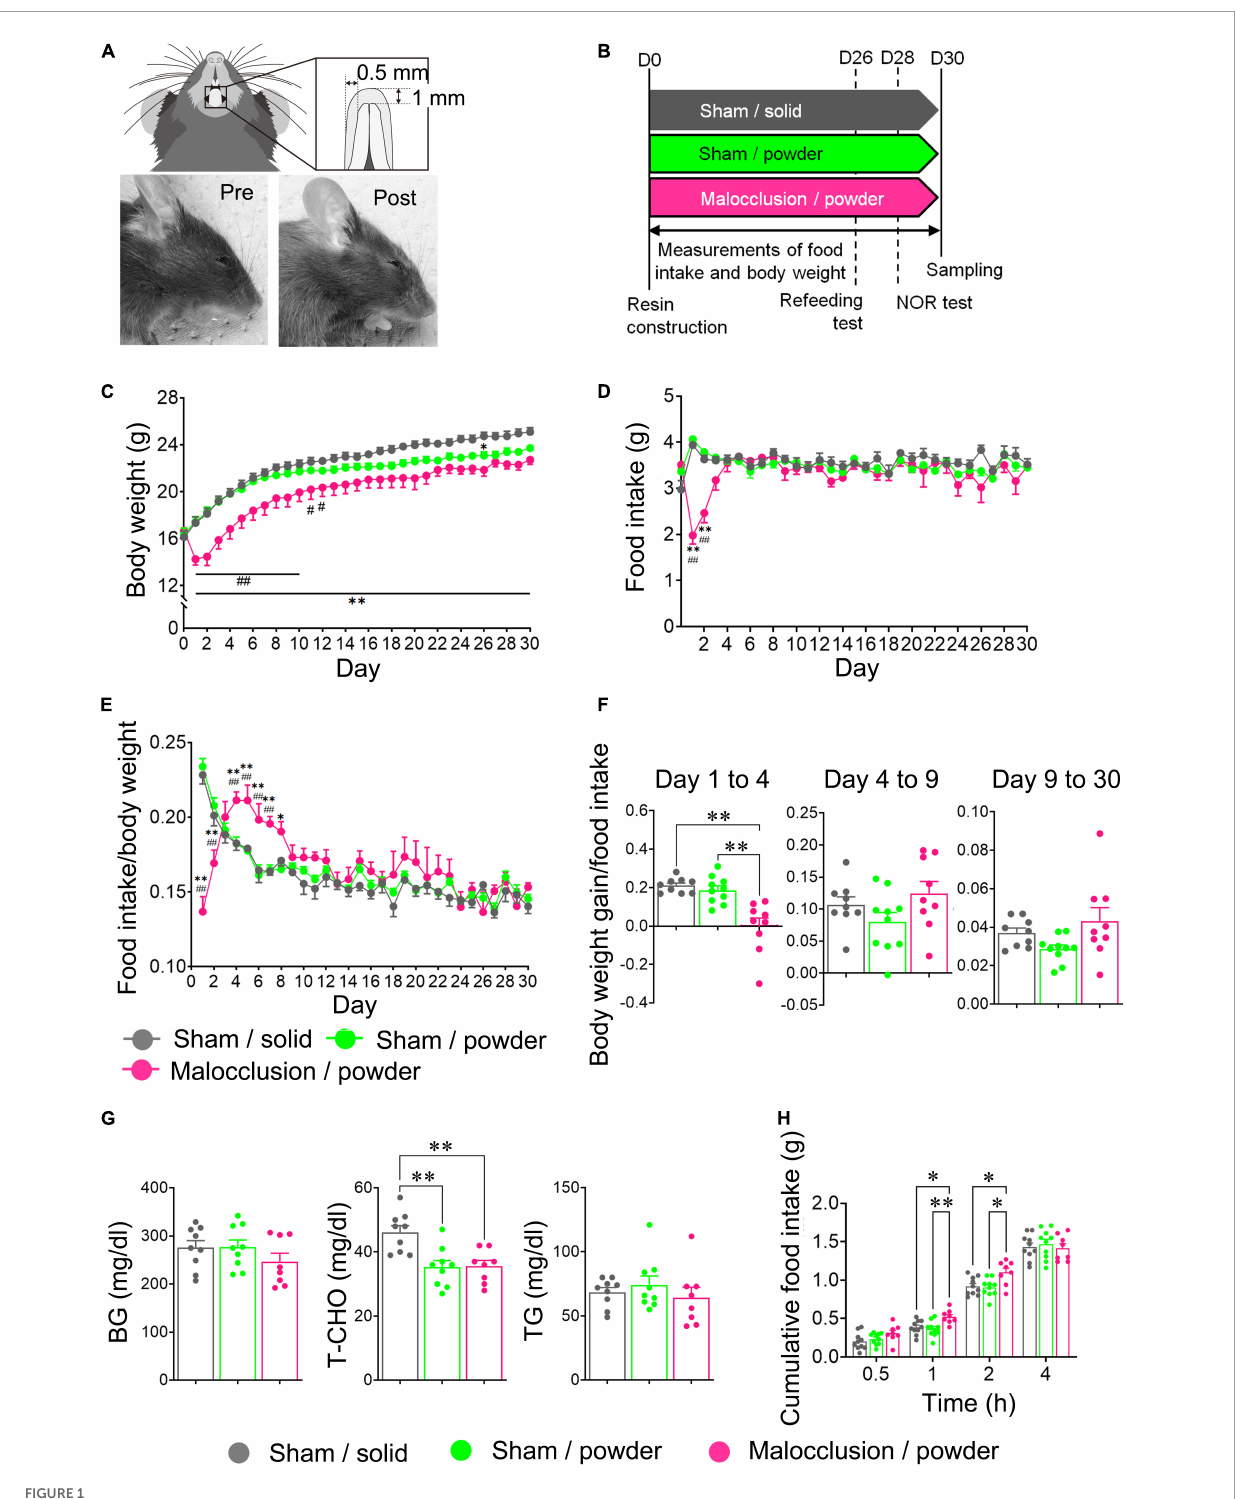
FIGURE1 Photographs and schematic diagram of occlusal disharmony in mice, schedule diagram, and body weight and food intake time courses. (A) Representative image of malocclusion (1 mm increase in vertical height) induced by cementing composite resin onto mandibular incisors of mice. (B) Mice were assigned to Sham operation with solid chow (Sham/solid, n = 9), Sham operation with powder chow (Sham/powder, n = 10), or application of composite resin on mandibular anterior teeth with powder chow (Malocclusion/powder, n = 9) group. Experiments were performed according to the schedule shown. Body weight (C) and food intake (D ) were measured for 30 d under experimental conditions. Food intake/body weight (E) and body weight gain/food intake from Day 1 to 4, Day 4 to 9, and Day 9 to 30 (F) were calculated. (G) Blood glucose (BG), total cholesterol (T-CHO), and triglyceride (TG) concentrations in peripheral blood were measured. (H) Cumulative food intake was measured in other mice: Sham/solid ( n = 10), Sham/powder ( n = 10) and Malocclusion/powder group ( n = 8) after 16 h fasting. Data are represented as means ± SEM. In panels (C–E) differences were considered significant at * p < 0.05 and ** p < 0.01 compared with Sham/solid group, and at # p < 0.05 and ## p < 0.01 compared with Sham/powder group. In panels (F–H) differences were considered significant at * p < 0.05 and ** p <